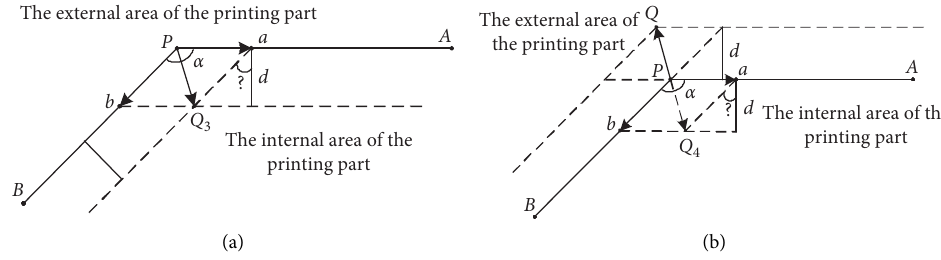
Figure 2: Contour profile point (P) in case 1. (a) The contour points are offset inward. (b) The contour points are offset outside.